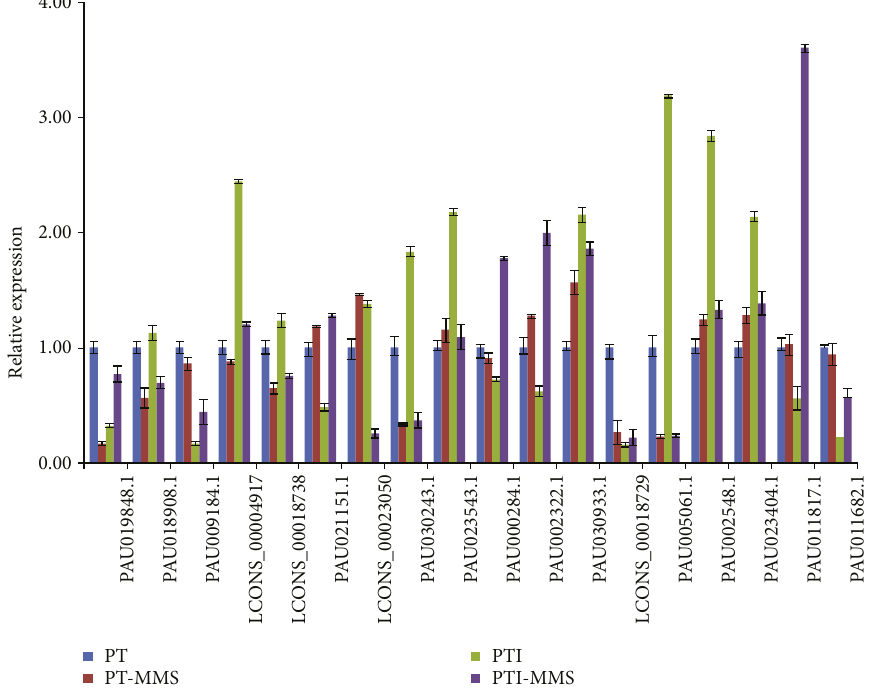
Figure 5: Changes in the relative expression levels of target genes in P. tomentosa